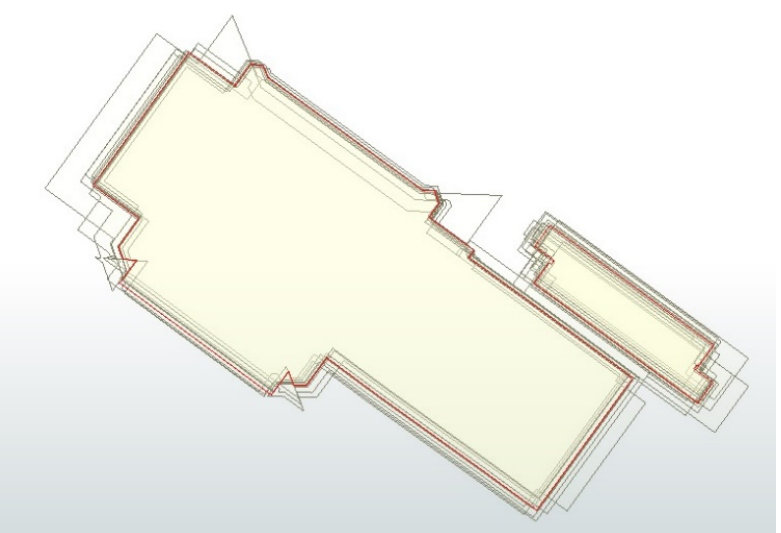
Figure 8. Example of generated position deviations, whereby the iteration steps (0.25 m, 0.5 m, …, 4.75 m and 5 m) are overlaid. The red lines show the original